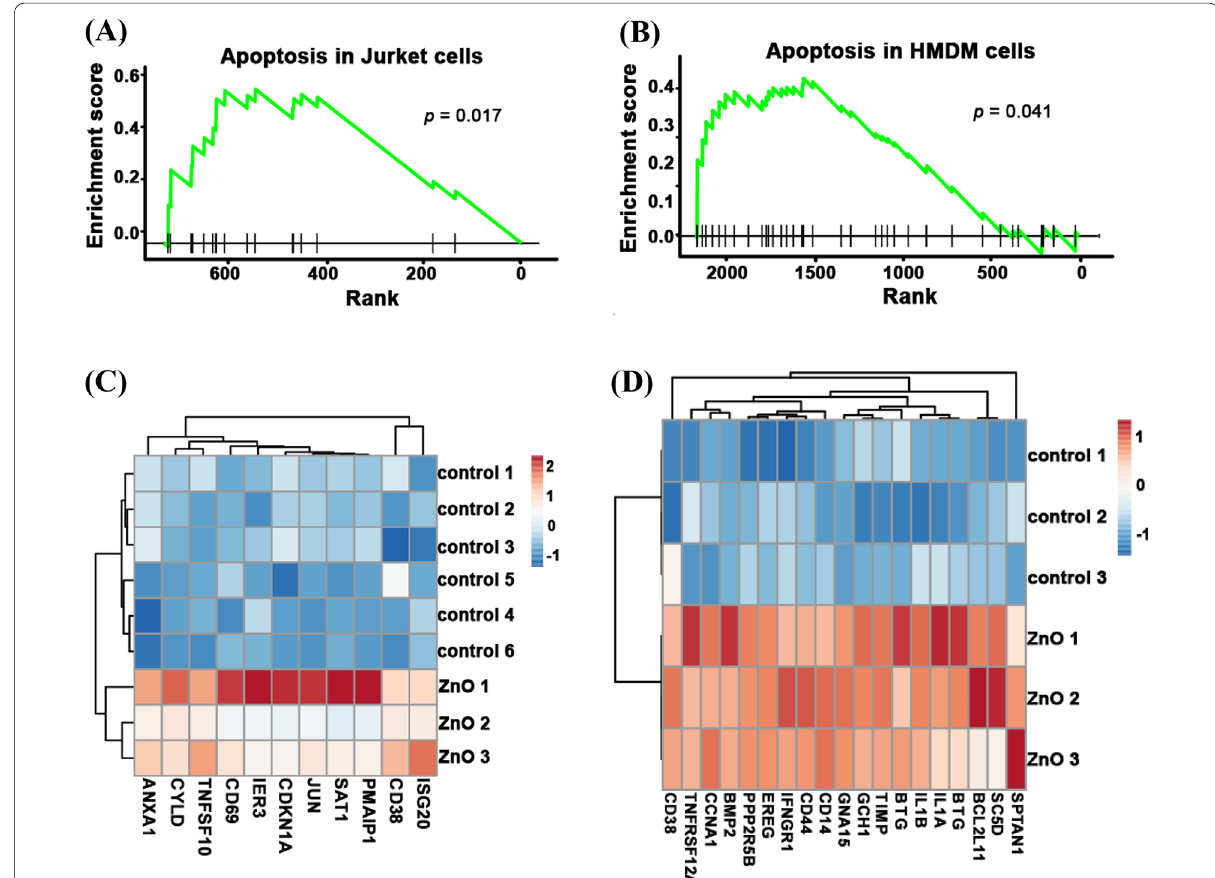
Fig. 4 Apoptosis pathway was enriched in RNA-seq data of fresh ZnO NP-treated Jurket and HMDM cells. The enrichment score of significantly expressed genes from apoptosis pathway of fresh ZnO NP-treated Jurket cells ( A ) and HMDM cells ( B ). The heatmap of apoptotic gene expression of fresh ZnO NP-treated Jurket cells ( C ) and HMDM cells ( D ) and their control